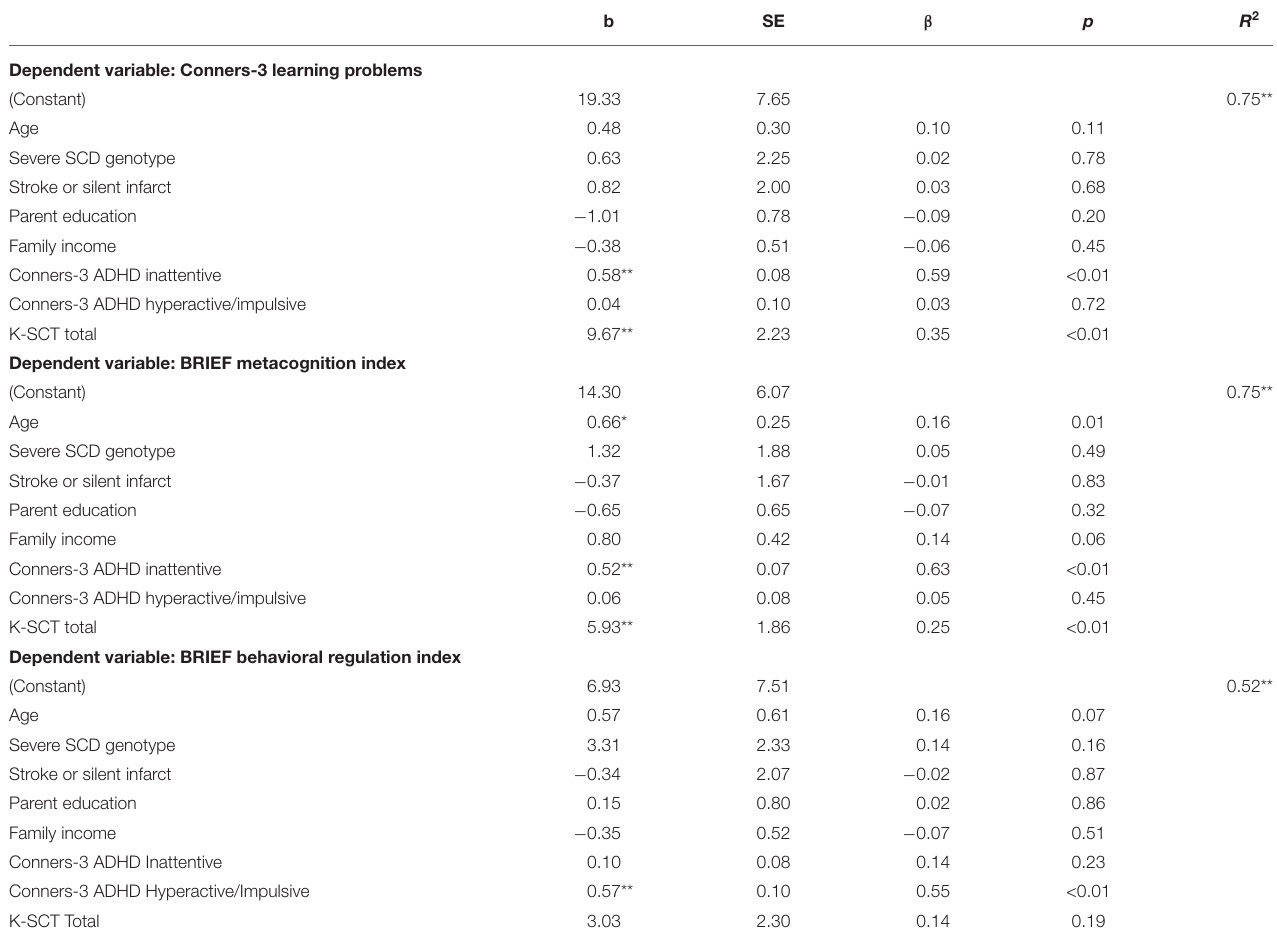
TABLE 3 | Multiple regression models predicting functional outcomes.